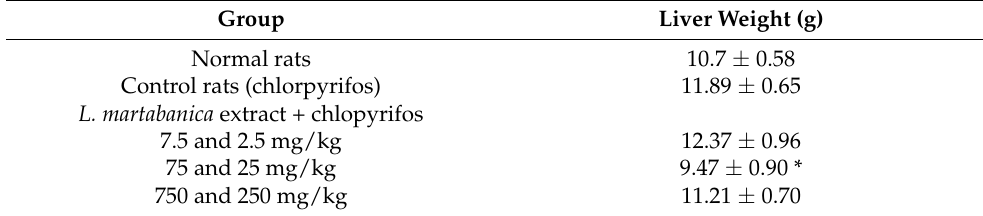
Figure 8. The effect of L. martabanica water extract on the body weight of rats. Values are expressed as mean ±S.E.M. ( n = 6). a Significantly different from normal rats ( p < 0.05), according to one-way ANOVA. Table 4. Effect of L. martabanica water extract on the liver weight of rats.